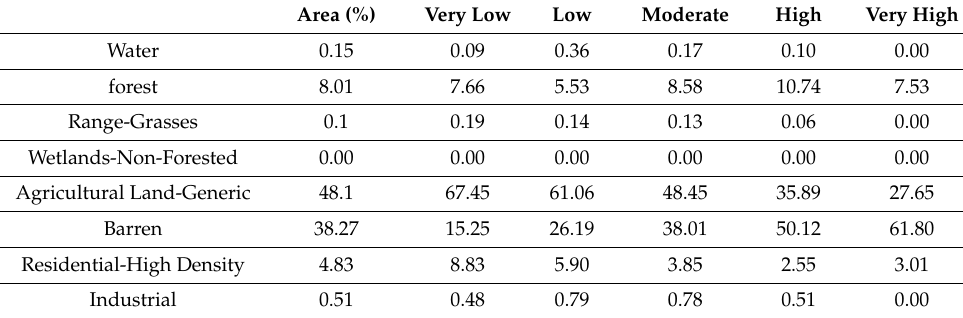
Table 8. Soil erosion rate in relation to land use using RUSLE equation.